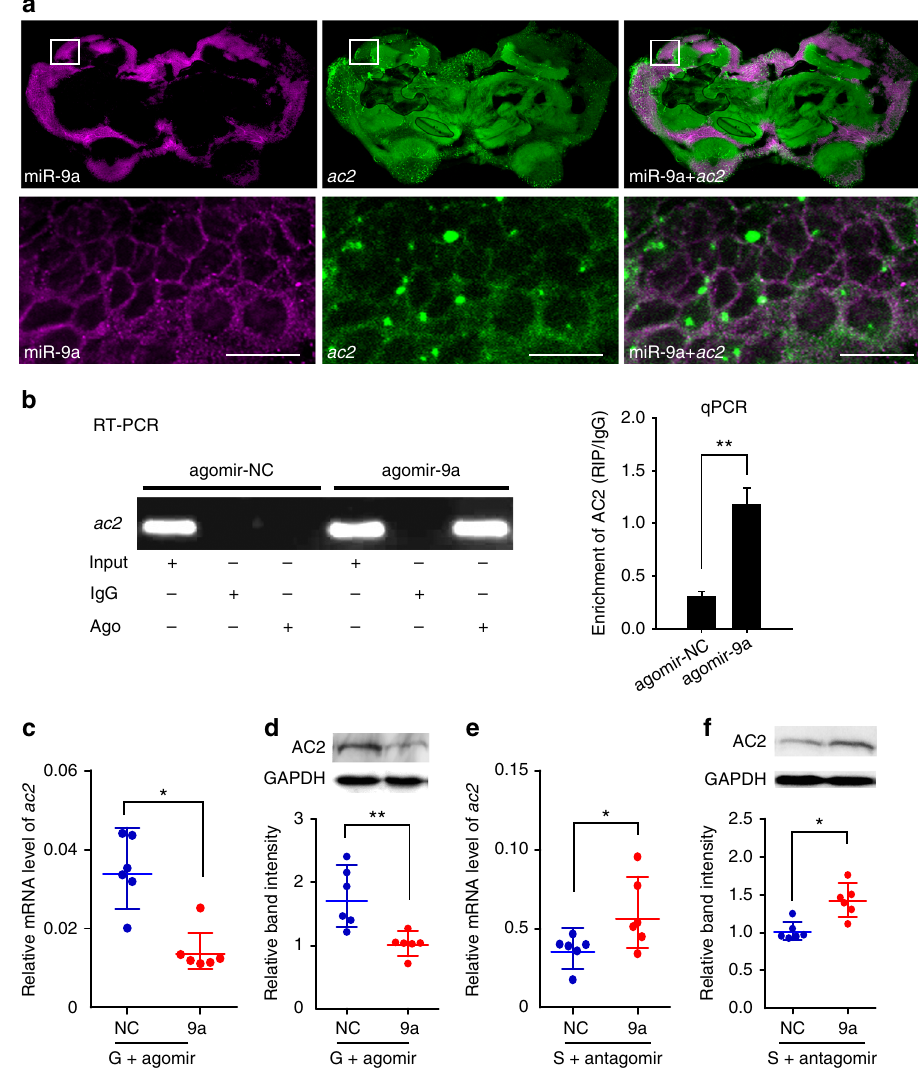
Fig. 5 miR-9a inhibits ac2 mRNA and protein expression by direct interaction. a Co-localization of miR-9a and ac2 in the locust brain through the co- labeling of miRNA and mRNA with fl uorescence in situ hybridization. The squares speci fi cally indicate the areas where miR-9a and ac2 were localized in the Kenyon cells of mushroom body. A white signal is observed in the area with magenta (miR-9a) and green signals ( ac2 ) overlapping, indicating the co- localization of miR-9a and its target. The images were visualized using an LSM 710 confocal fl uorescence microscope (Zeiss) at magni fi cations of ×10 (the upper row) and ×20 (the bottom row). Scale bar represents 20 μ m. b RNA immunoprecipitation (RIP) was performed with an anti-Ago-1 antibody; normal mouse IgG was used as a negative control. RT-PCR or qPCR analysis was performed to amplify ac2 mRNA from the Ago-1 immunoprecipitates in brain tissue extracts treated with agomir-9a compared with agomir-control (agomir-NC). c , d Relative mRNA level ( c , n = 6) and protein level ( d , n = 6) of ac2 in the brains of the gregarious locusts injected with agomir-9a. e , f Relative mRNA level ( e , n = 6) and protein levels ( f , n = 6) of ac2 in the brains of the solitarious locusts injected with antagomir-9a. The data for RIP assay, qPCR, and Western blot are presented as the mean ± SEM; The asterisks outside the strip indicate the signi fi cant difference between controls and the treatments by Student ’ s t -test. * P < 0.05; ** P < 0.01. S: solitarious, G: gregarious, NC: negative signi fi cantly reduced their olfactory attraction to gregarious (Supplementary Figure 6) abolished the suppression effects of volatiles ( G 2 = 9.16, P = 0.010), whereas phf20l1 knockdown ( t = 3.023, P = 0.009) (Supplementary Figure 7B) did not affect the miR-9a on the reporters with target sites from phf20l1 CDS, ac2 olfactory responses of solitarious locusts ( G 2 = 0.59, P = 0.744) CDS, and 3 ʹ UTR ( t = 5.050, P < 0.001 for phf20l1 CDS; t = 4.906, (Fig. 4e). In addition, we detected the olfactory responses of P < 0.001 for ac2 CDS; t = 3.611, P = 0.004 for ac2 3 ’ UTR) gregarious locusts after phf20l1 knockdown ( t = 3.818, P = 0.002) (Fig. 4d). Thus, phf20l1 and ac2 are the putative target genes of (Supplementary Figure 8A), and we found that phf20l1 knock- miR-9a. down did not change the olfactory preference of gregarious To determine the functions of phf20l1 and ac2 in the locust locusts ( G 2 = 0.23, P = 0.892) (Supplementary Figure 8B). These olfactory responses, we injected dsRNA of phf20l1 and ac2 into results indicate that ac2 , but not phf20l1 , is involved in locust the brain of solitarious and gregarious locusts, respectively. At 72 olfactory preference. h after the injection, ac2 knockdown ( t = 2.677, P = 0.023) (Supplementary Figure 7A) in the brains of gregarious locusts